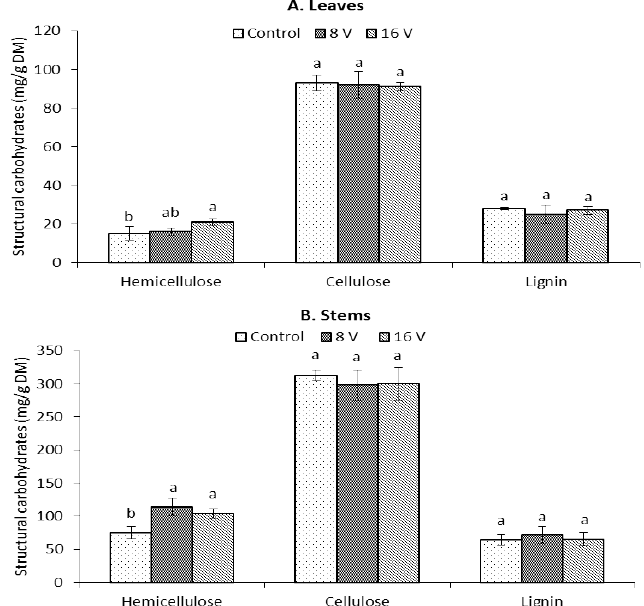
Fig. 5: Effect of different voltage applications on different structural carbo- hydrates on leaves (A) and Stems (B) of African nightshade plants. Mean values (± standard deviation) within a specific variable follo - wed by the same letter are not significantly different according to Tukey-test ( p <